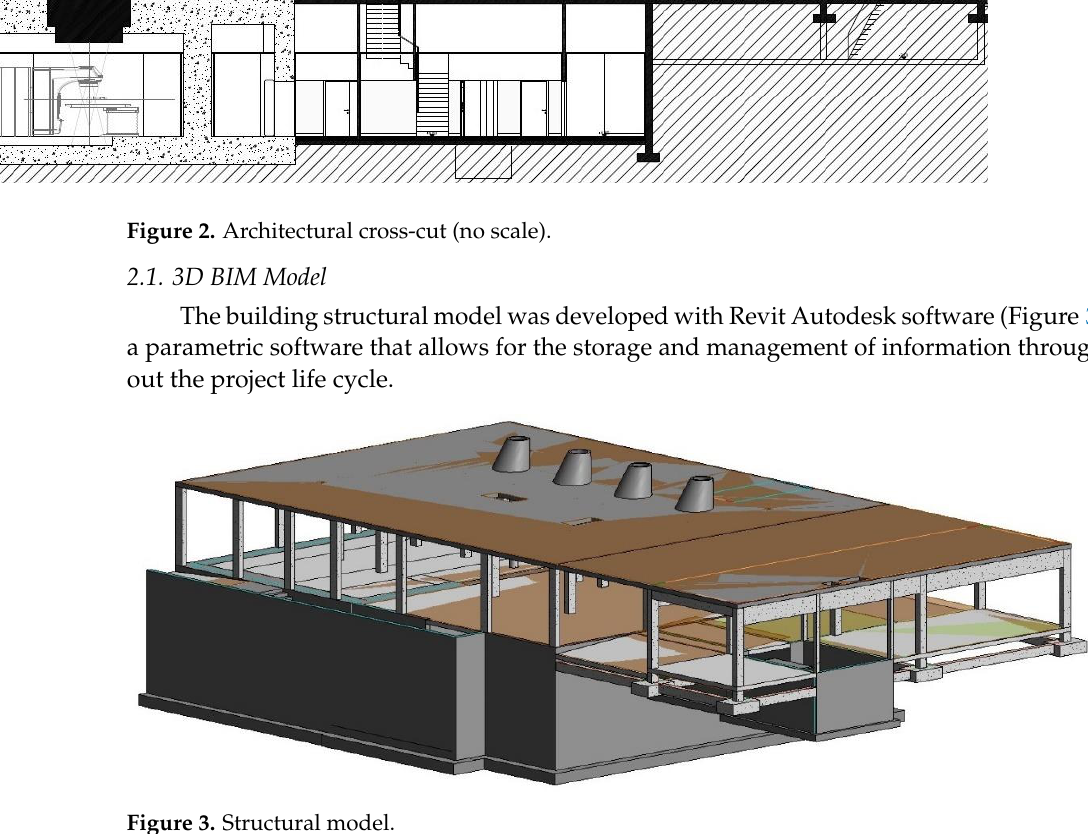
Figure 3. Structural model.